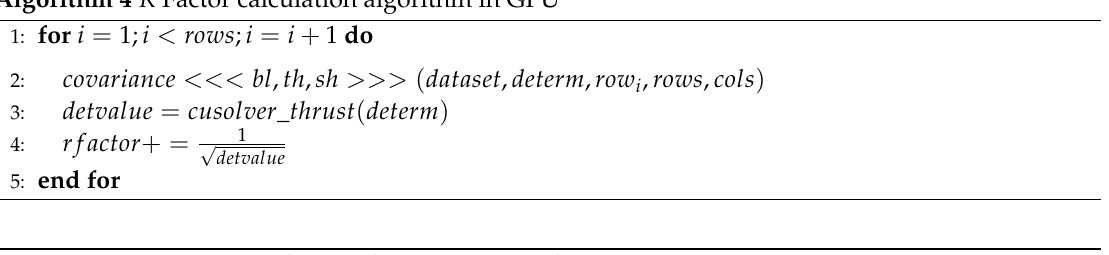
Algorithm 5 Covariance ( dataset , determ ,p, rows , cols